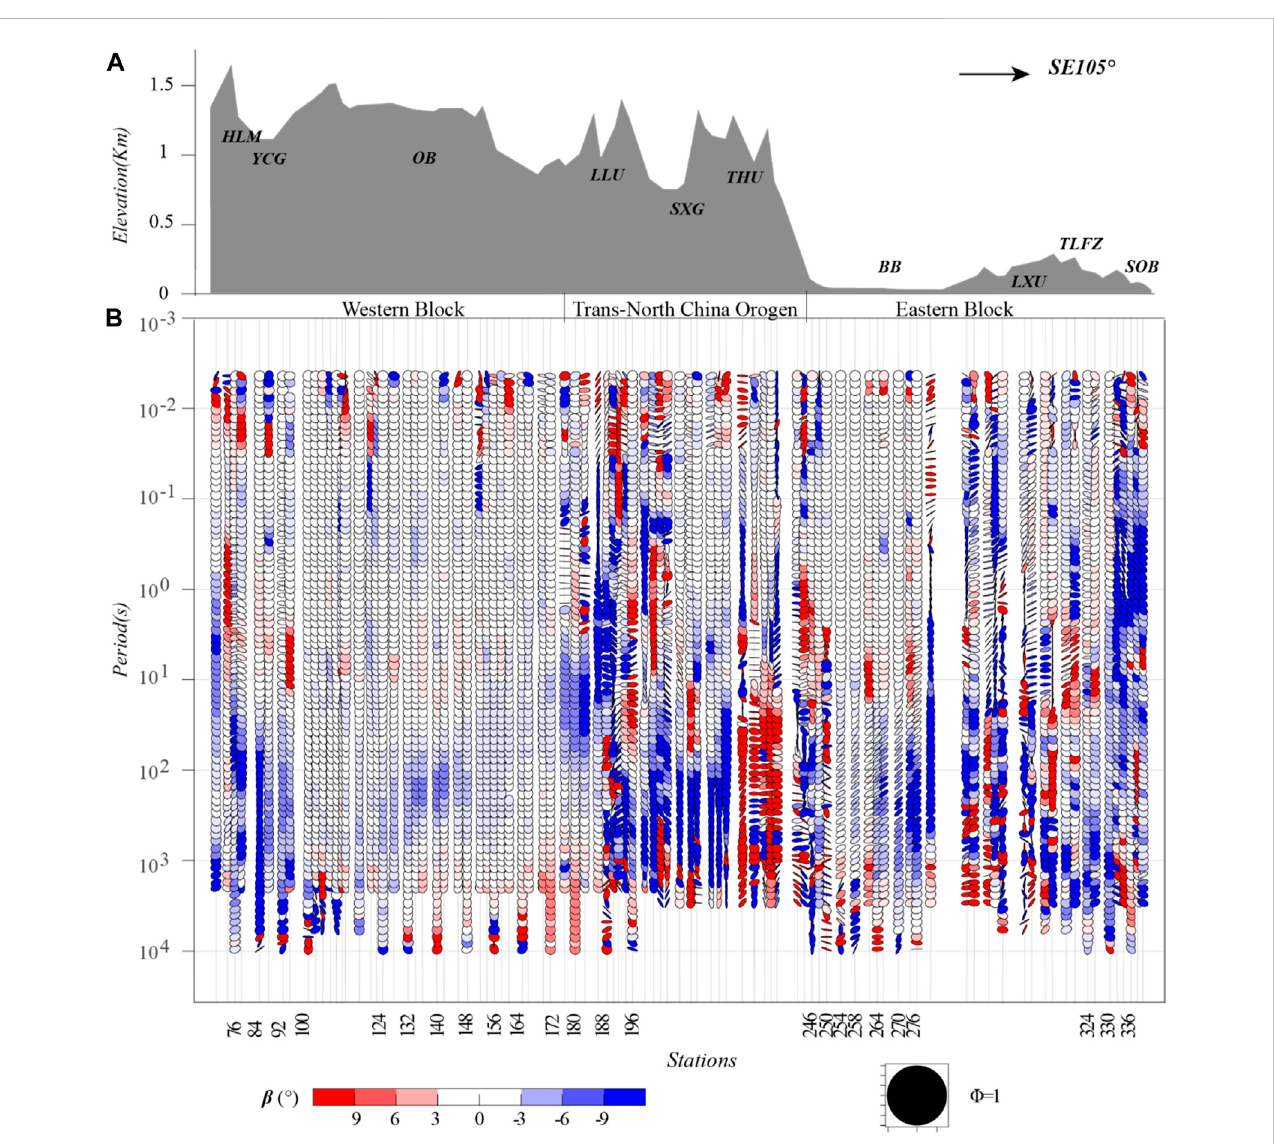
FIGURE 4 (A) The topography along the AR pro fi le cut from ETOPO30. HLM: Helan Mountain, YCG: Yinchuan Graben, OB: Ordos Block, LLU: Lüliang Uplift, SXG: Shanxi Graben, THU: Taihang Uplift, BB: Bohaiwan Basin, LXU: Luxi Uplift, SOB: Sulu Orogenic Belt, and TLFZ: Tan-Lu Fault Zone. (B) The results of phase tensor analysis for all periods and all stations with the MTpy package (Krieger and Peacock,